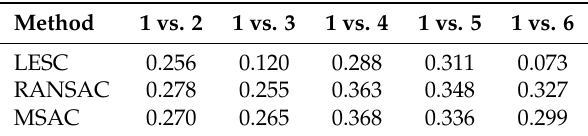
Table 5. The computation time (in seconds) of LESC, RANSAC and MSAC respectively on the Bikes sequence using the 1st image versus the rest of